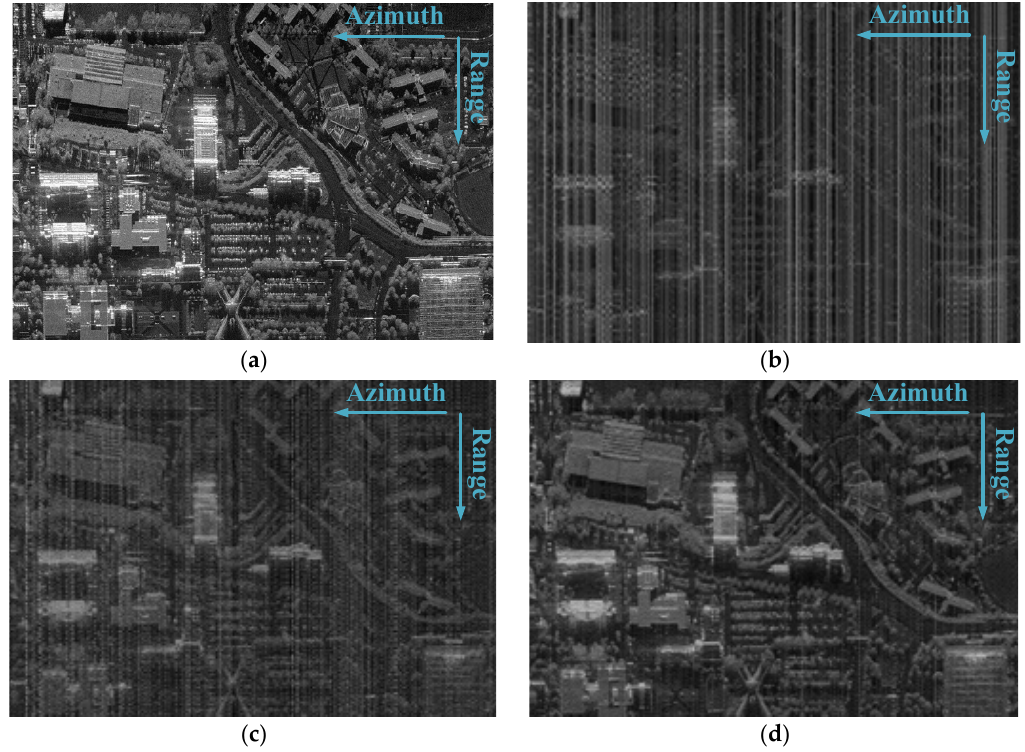
Figure 2. Comparison of focused SAR images with different interference to signal ratios (ISRs). ( a ) Original SAR image; ( b ) ISR = 10 dB; ( c ) ISR = 5 dB; ( d ) ISR = –5 dB.